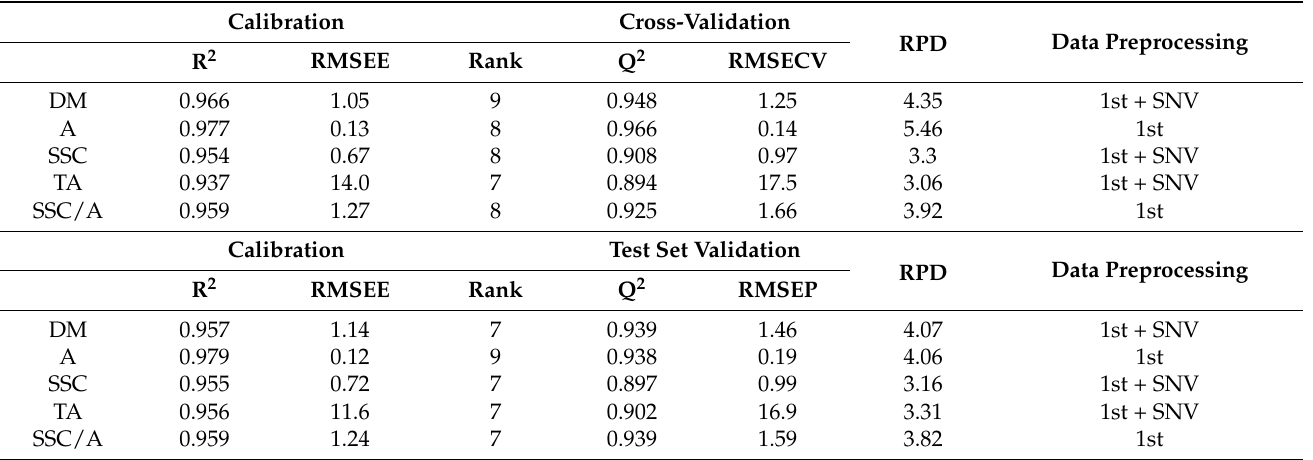
Table 5. Statistical characteristics of PLS regression as a result of five segments cross- and test-validation.